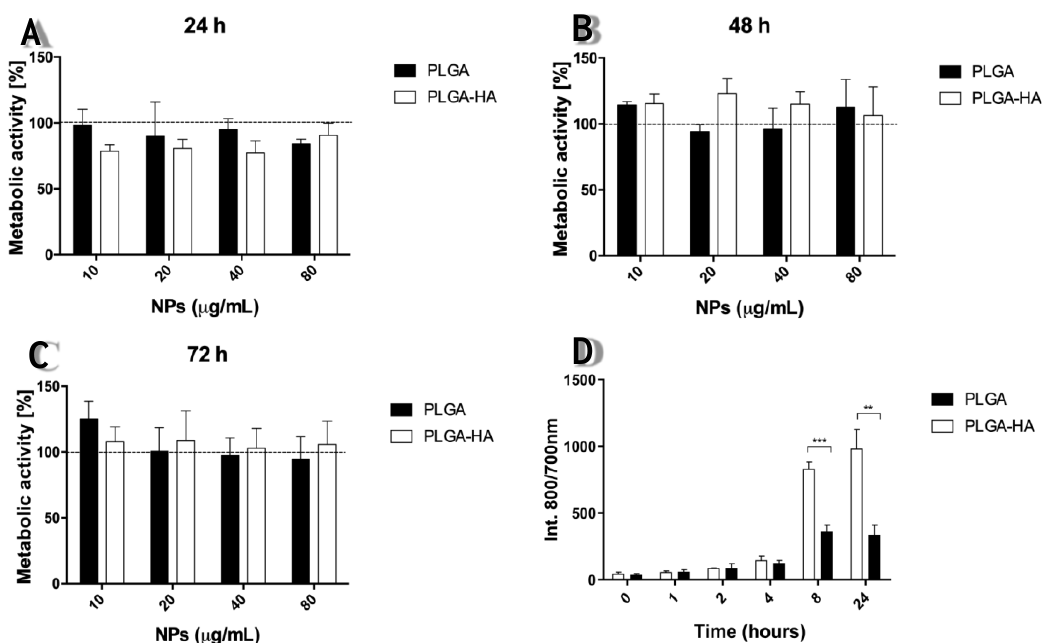
Figure 5. Cell metabolic activity assay (MTS) of the 2 different NPs incubated with the C28/I2 cell line at different concentrations. Metabolic cell activity was measured at three time points: ( A ) 24 h, ( B ) 48 h, and ( C ) 72 h. For each assay, the positive control was obtained using DMSO 50% and the negative control was obtained with only the cells. The negative controls are indicated by the black horizontal line. ( D ) Binding assay of PLGA and PLGA-HA NPs incubated with the C28/I2 cell line at the concentration of 40 μg/mL, measured at different time points after NPs’ incubation. There was no statistically significant difference ( p > 0.05) between PLGA NPs and PLGA-HA NPs at time points 0, 1, 2, and 4 h. ** Indicates statistically significant difference ( p < 0.05) between PLGA NPs and PLGA-HA NPs after 8 h of NPs’ and cells’ incubation. *** Indicates statistically significant difference ( p < 0.001) between PLGA NPs and PLGA-HA NPs after 24 h ( n = 3).